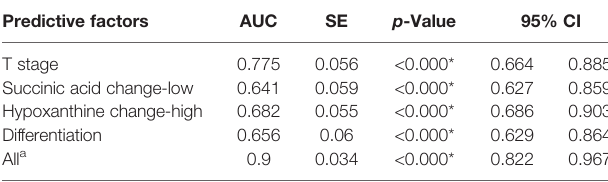
TABLE 3 | Summary of the RFS predictive accuracy of succinic acid and hypoxanthine. Predictive factors